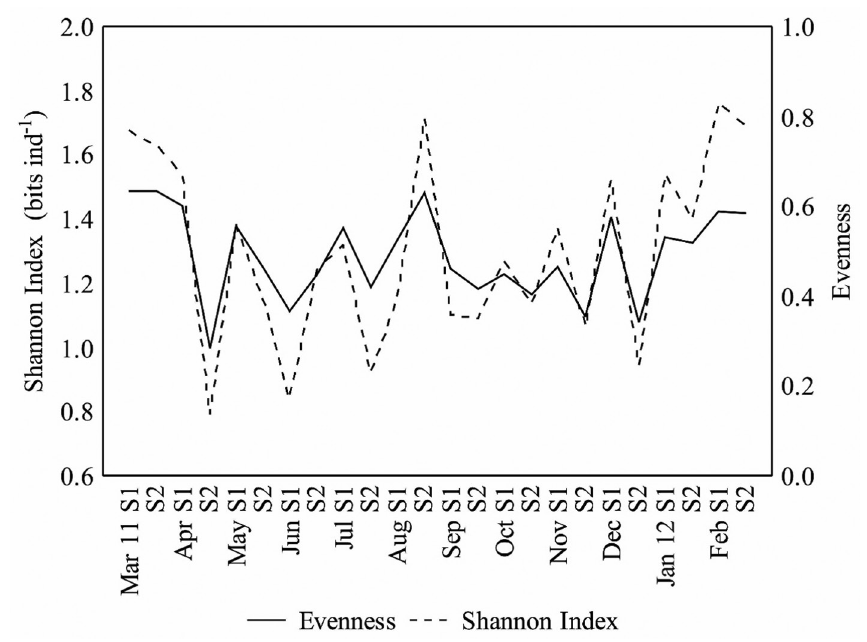
Figure 5. Spatial and temporal variation of the Shannon diversity and evenness in the stabilization